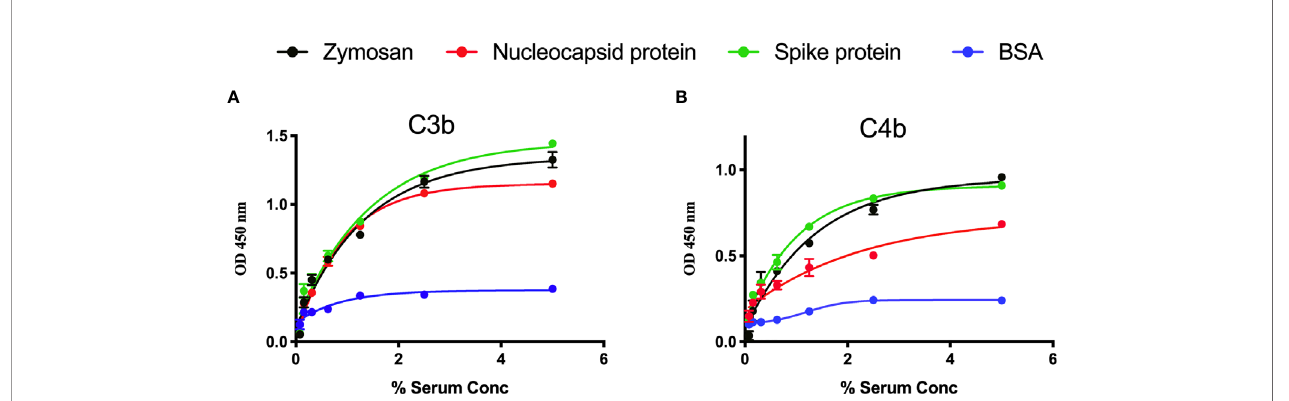
FIGURE 2 | Detection of C3b and C4b deposition on SARS-CoV-2 proteins. An ELISA plate was coated with SARS-CoV-2 proteins (S or N) or zymosan and incubated with serial dilutions of NHS (starting at 5%) for 1 h at 37°C. C3b or C4b deposition were detected using antibodies against human C3c or C4c. High levels of C3b (A) and C4b (B) deposition were observed on surface immobilised SARS-CoV-2